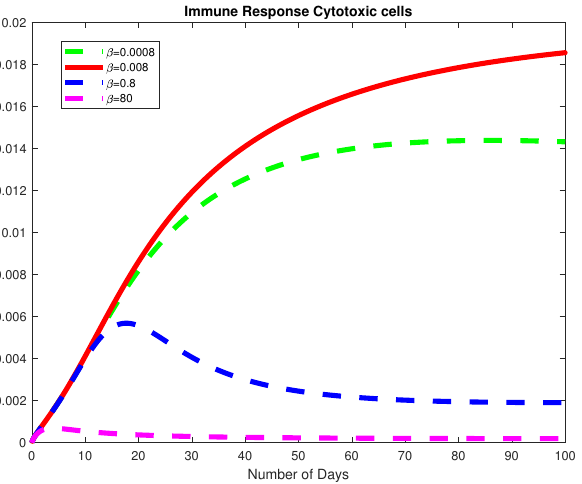
Figure 12. The dynamics of the Infected Hepatocytes ( I ) for varying values of β .